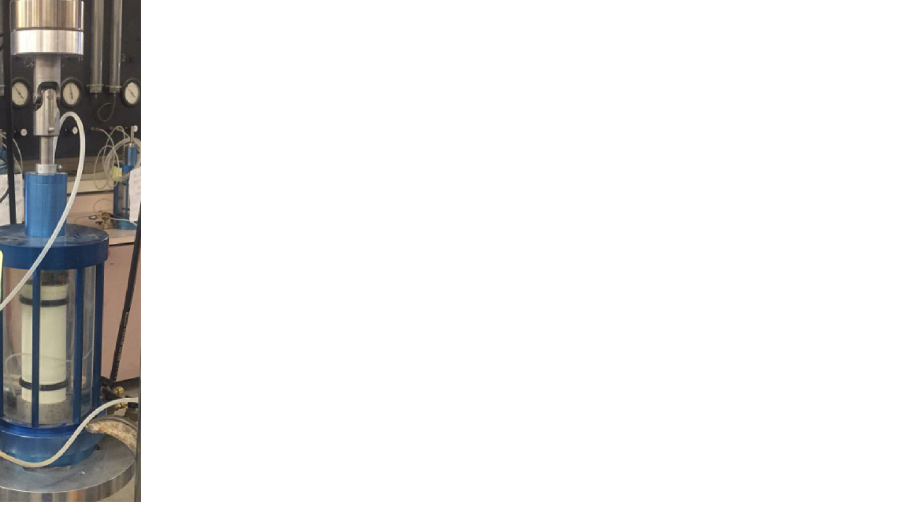
Figure 2. A Typical triaxial cell.